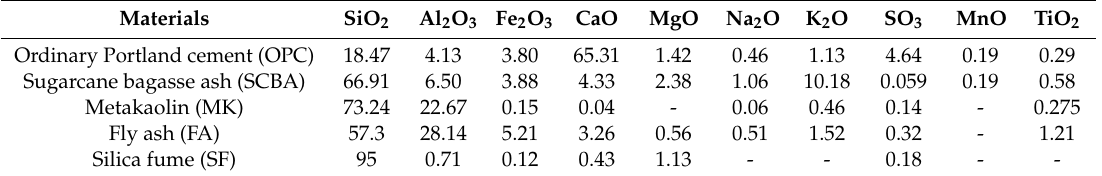
Table 1. Chemical composition of the materials (wt %).